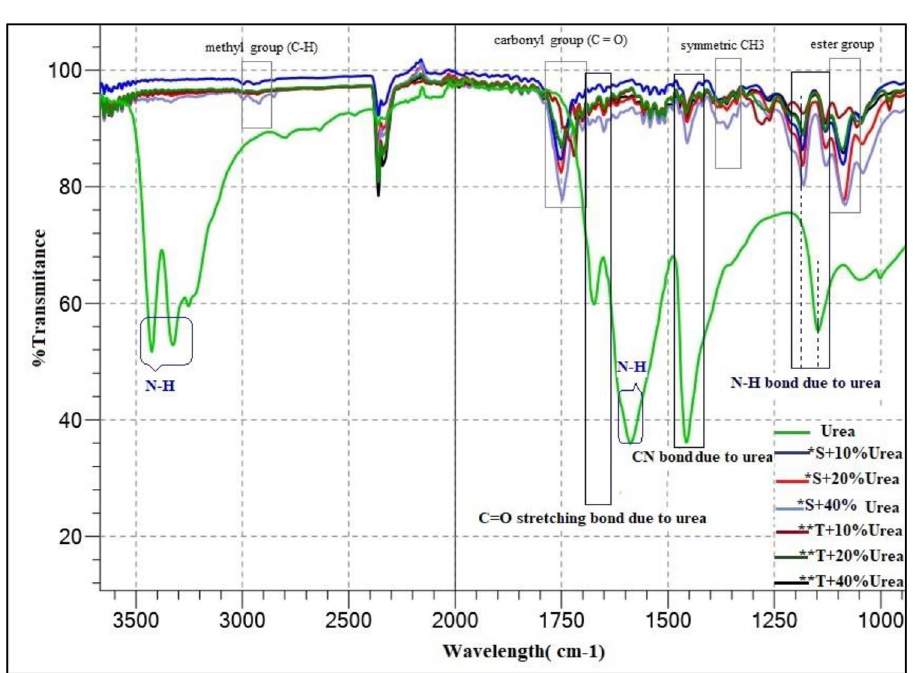
Figure 2 . FTIR spectra of urea and single-, triple-layered PLLA nanofibres loaded with urea. Pure urea (Urea), PLLA nanofibre containing 10% urea (*S+ 10%Urea), PLLA nanofibre containing 20% urea (*S+ 20%Urea), PLLA nanofibre containing 40% urea (*S+ 40%Urea), PHB/PLLA/PHB nanofibre containing 10% urea (**T+ 10%Urea), PHB/PLLA/PHB nanofibre containing 20% urea (**T+ 20%Urea), PHB/PLLA/PHB nanofibre containing 40% urea (**T+ 40%Urea). *S: Single-layered PLLA nanofibre mat, **T: Triple-layered PHB/PLLA/ PHB nanofibrous